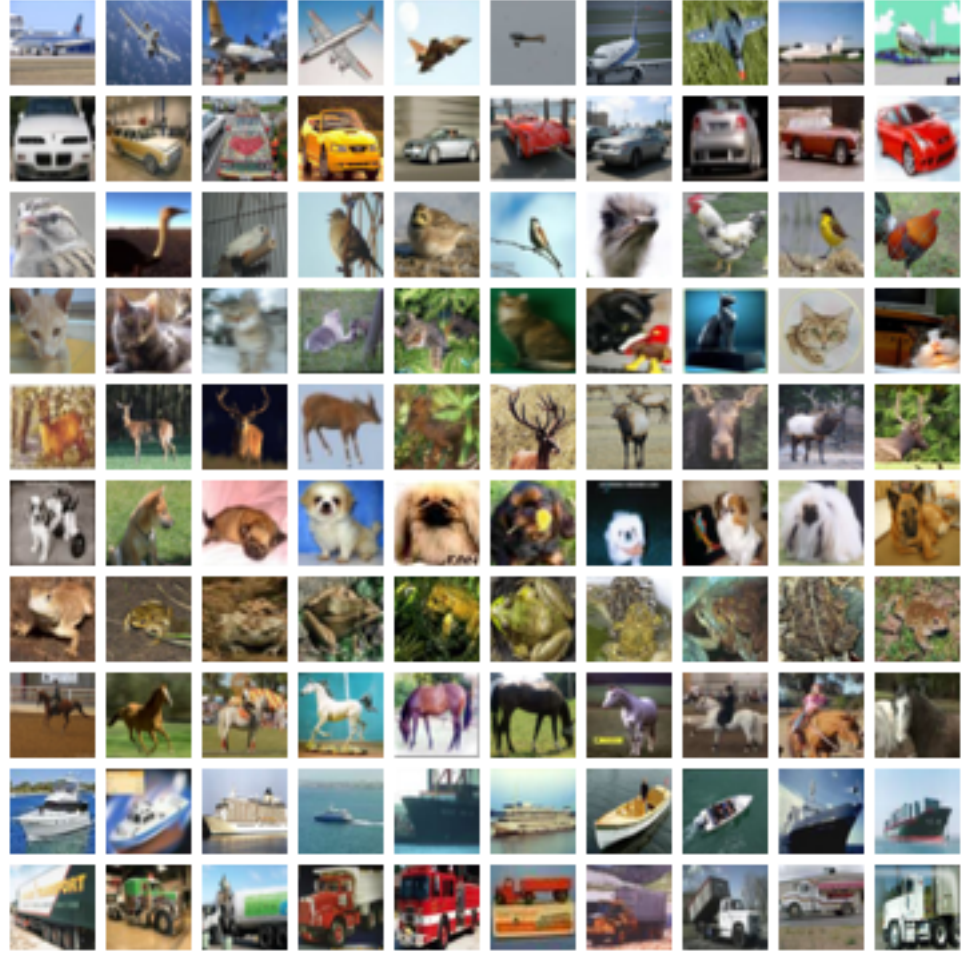
Figure 1. An Example of Object Classification in Images (image source: [30]). When an input image is given, the proposed approach is required to classify the image into a class, e.g., a car or airplane, within the deadline via adaptive deep